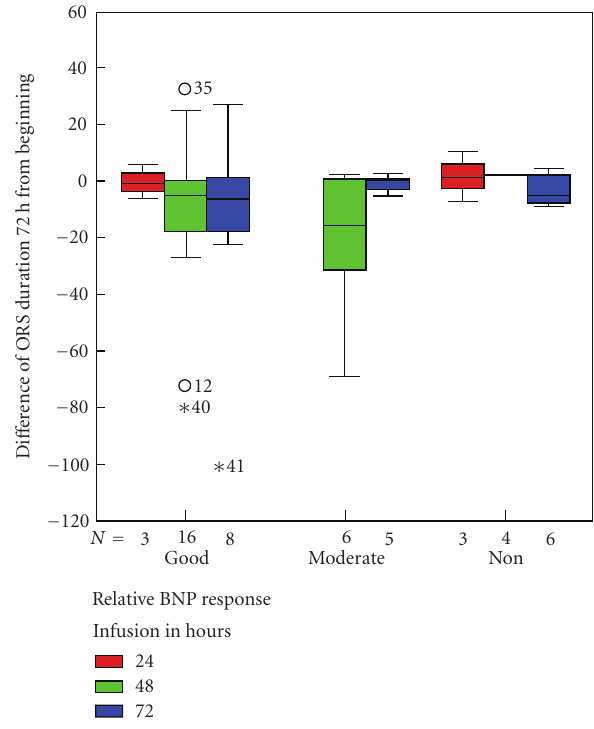
Figure 3: Di ff erences of BNP response and filtered QRS duration between infusion